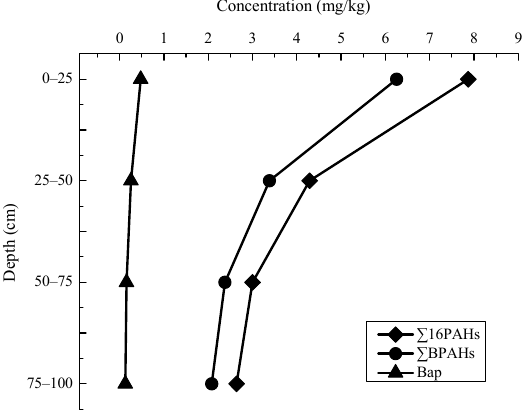
Figure3. Vertical distribution pro fi le of the total PAHs ( ∑ 16PAHs), total carcinogenic PAHs ( ∑ BPAHs) and Bap in the soil profiles of samples around the chemical plant